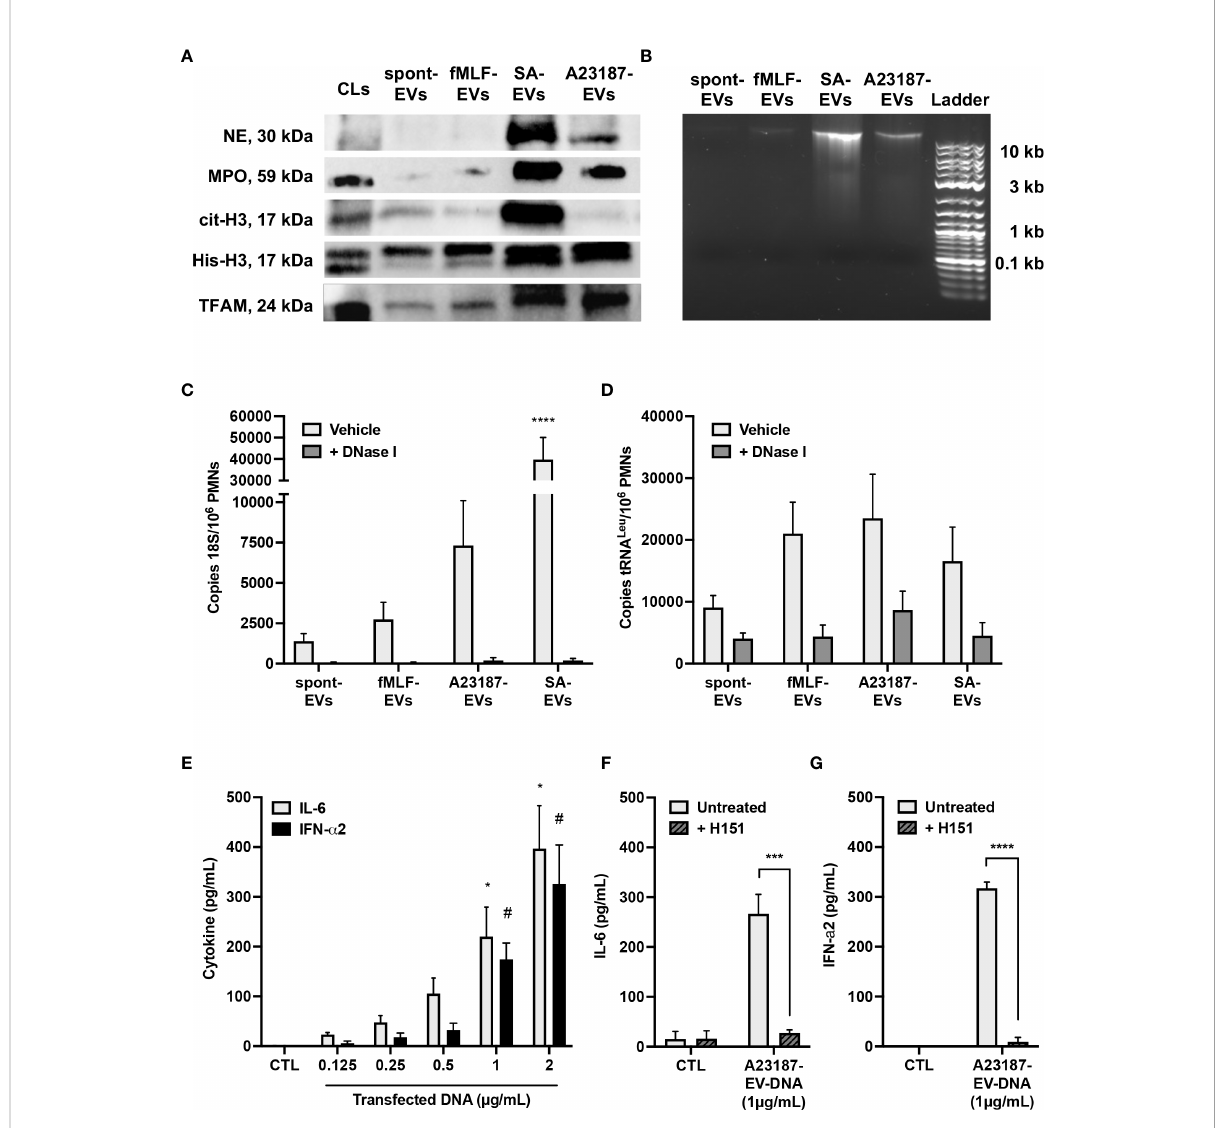
FIGURE 2 A23187-EVs associated with NET proteins and DNA, and transfected DNA activated cGAS-STING. Neutrophil elastase (NE), myeloperoxidase (MPO), citrullinated histone H3 (cit-H3), histone H3 (His-H3), and TFAM were detected by immunoblotting. Equivalent protein concentrations of cell lysates (CL) and EVs were separated by SDS-PAGE prior to immunoblotting (1µg for MPO; 3µg for NE, cit-H3, and His-H3; 9µg for TFAM). Shown are representative images of four experiments (A) . EV-DNA was isolated from EV subsets and resolved with gel electrophoresis. Shown is a representative image of fi ve experiments (B) . EVs were treated or without with DNase I for 1 hour prior to isolating DNA. Primers speci fi c for 18S rRNA and tRNA Leu were used to amplify nuclear (C) and mitochondrial (D) DNA, respectively, and DNA copy numbers were quanti fi ed by ddPCR. Values are expressed as DNA copies per EV-cell equivalents. Bars represent the average of three or more experiments ± SEM. P- values were determined using a two-way ANOVA with Dunnett ’ s post-test (**** p < 0.0001 vs. spontaneous-EVs). A23187-EV-DNA was transfected for 18 hours at the indicated concentrations, and cytokines in supernatants were measured by ELISA (E , n=3 ) . Bars represent the average of experimental data ± SEM. P values were determined using a two-way ANOVA with Sidak ’ s post-test (* p < 0.05 vs. CTL, # p < 0.05 vs. CTL). EV- DNA was isolated from A23187-EVs and then encapsulated in DOTAP. Macrophages were pre-treated with and without H151 (1 µM), then transfected for 18 hours. Supernatants were collected and analyzed by ELISA for IL-6 (F , n=4 ) and IFN- a 2 (G , n=3 ) . Bars represent the average of experimental data ± SEM. P values were determined using a two-way ANOVA with Sidak ’ s post-test (*** p < 0.001, **** p <